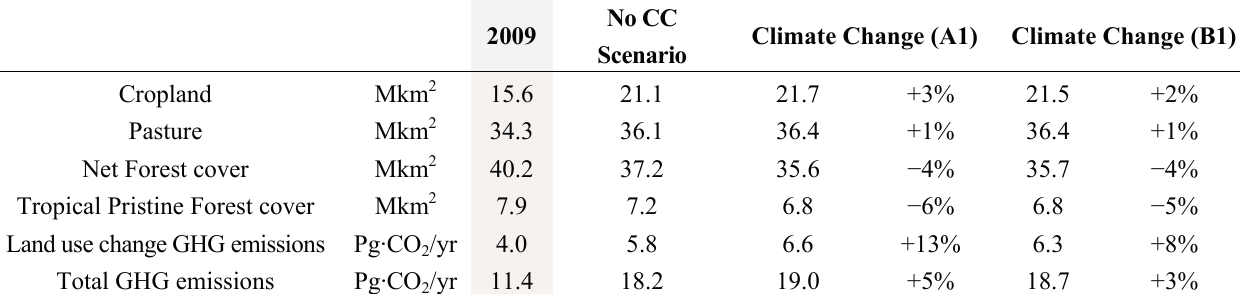
Table 4. The overall results of modelling agricultural impacts in 2050 under two climate change